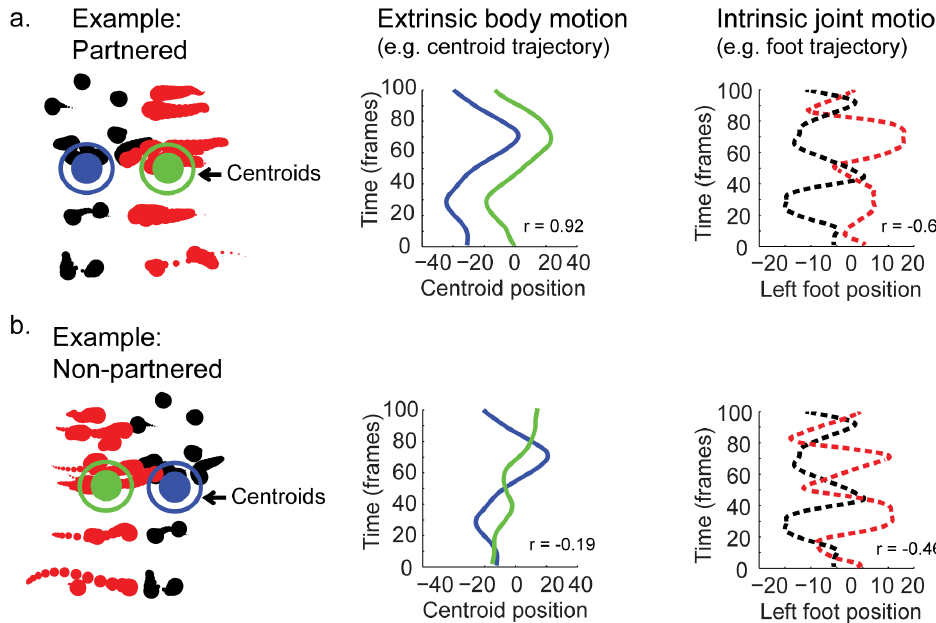
Figure 3. Schematic depiction of sample stimuli with plots showing motion profiles of extrinsic and intrinsic motion. (a) Left: Example of truly-partnered dancers. For visualization, one dancer is colored in red dots and the other in black dots. Dot size decreases for time points further in the past. Blue and green target symbols indicate roughly the centroid of the figure. Middle: Position of the centroid of each figure over time (in pixels), illustrating graphically the profile of extrinsic motion. Right: Position of the left foot point from each figure over time (in pixels) after subtracting extrinsic motion, illustrating the profile of intrinsic motion for an example joint. (b) Same as above, but for un-partnered dancers taken from two different ‘‘snippets’’. Notice there is a stronger inherent correlation (Pearson’s r ) between the intrinsic and extrinsic movements of dancers that are truly-partnered versus un-partnered.